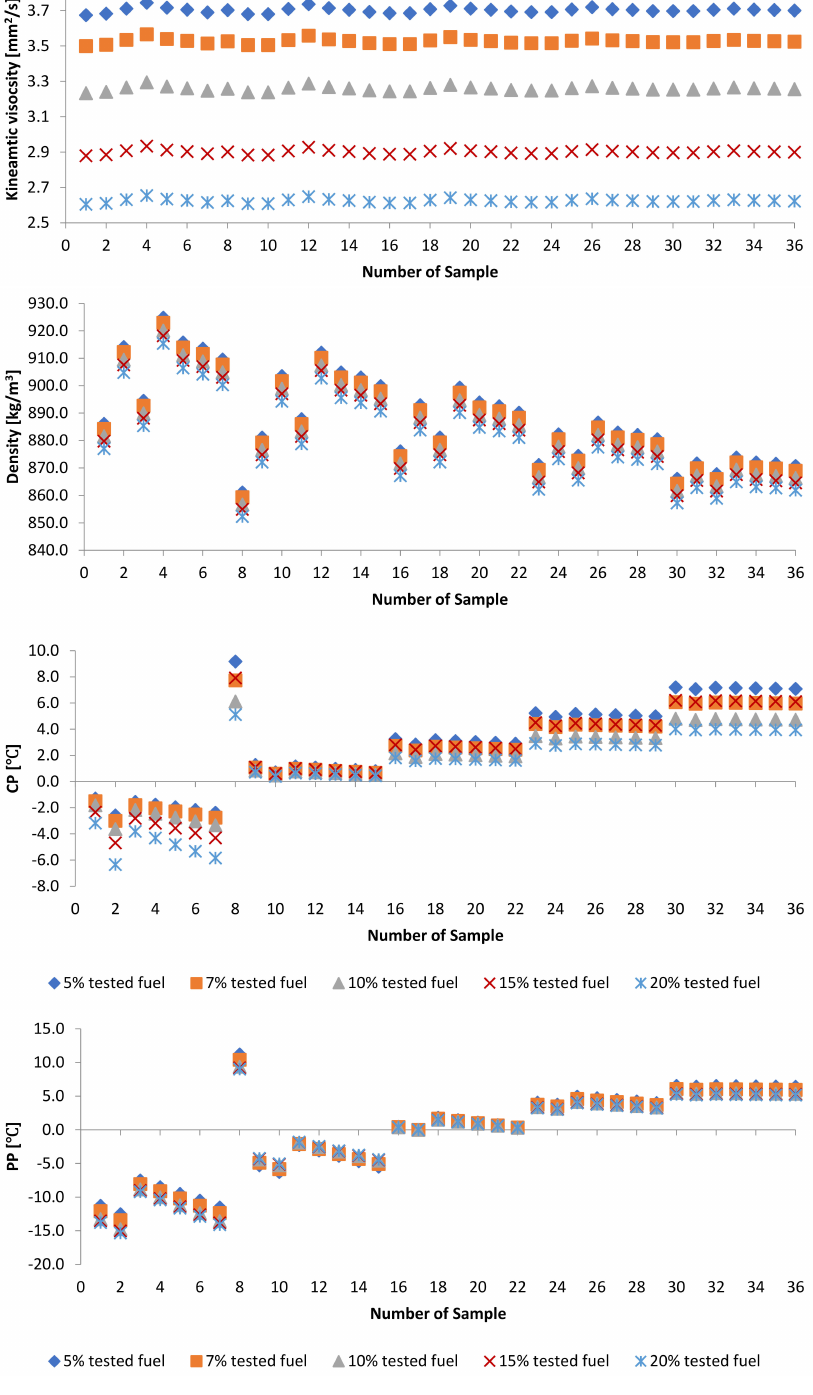
Figure 13. Properties of WFME-PME-KF with various volume